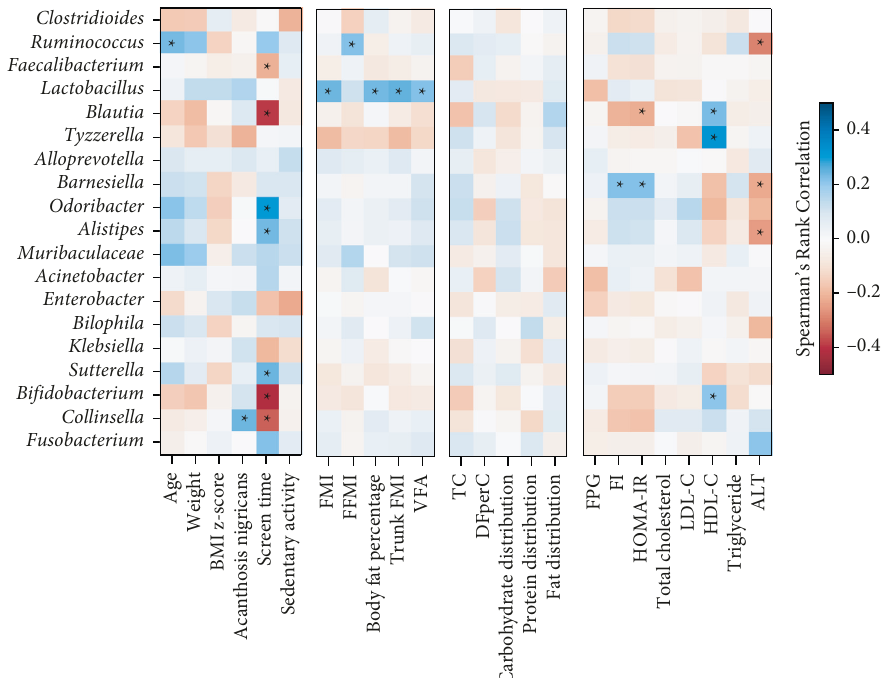
Figure 3: The relationships of the bacterial taxa at the genus level and clinical data, lifestyle activity, dietary intake, and metabolic profiles were determined using Spearman correlation and visualized using a heatmap. The color of the heatmap shows positive (red) and negative correlations (blue). Significant associations are marked with asterisks. ALT: alanine aminotransferase; DFperC: dietary fiber intake, g per 1,000kcal; FFMI: fat-free mass index; FMI; fat mass index; FI: fasting insulin; FPG: fasting plasma glucose; HDL-C: high density lipoprotein cholesterol; HOMA-IR: Homeostatic Model Assessment for Insulin Resistance; LDL-C: low density lipoprotein cholesterol; TC: total calories; VFA: visceral fat